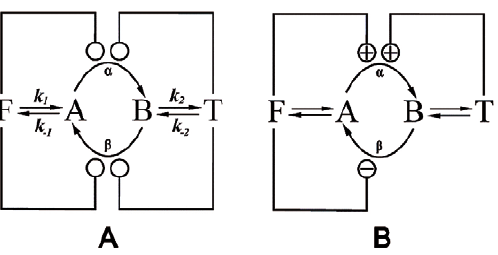
Figure 1. Diagram of the model. Substrate-cycle where enzymes a and b interconvert A into B (Fig. 1A), both regulated by external effectors F and T . Arrows indicate reactions, knobs indicate regulation. The kinetic parameters are: k 1 =10 2 2 s 2 1 ; k -1 =8 6 10 2 3 s 2 1 ; k 2 =10 2 2 s 2 1 ; k -2 = 4 6 10 2 3 s 2 1 . For enzyme a , V ma x = 1.6 mM s 2 1 , K m = 1.5 6 10 2 3 mM. For enzyme b , V max = 3.5 mM s 2 1 ,